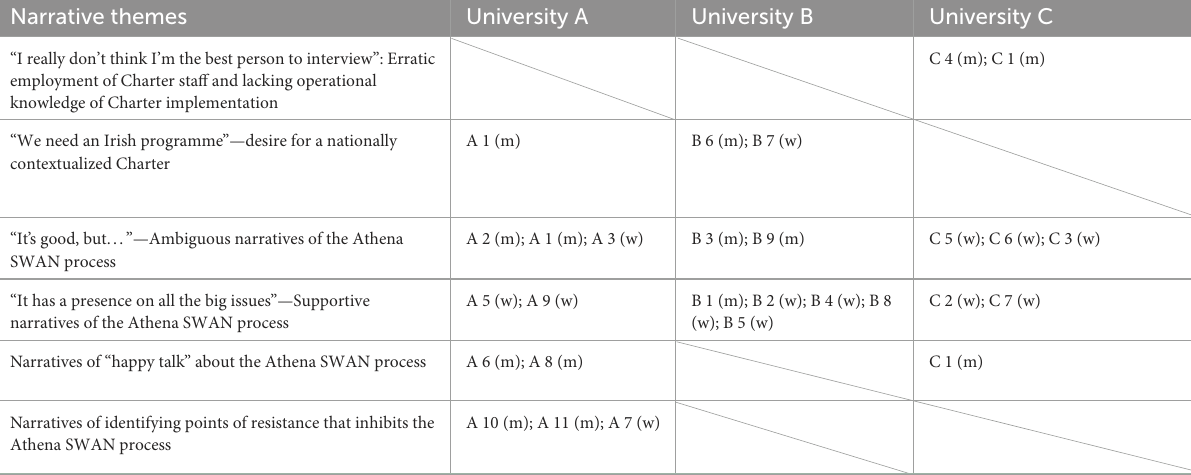
TABLE 2 The main themes extracted from narrative analysis across the three case universities. Narrative